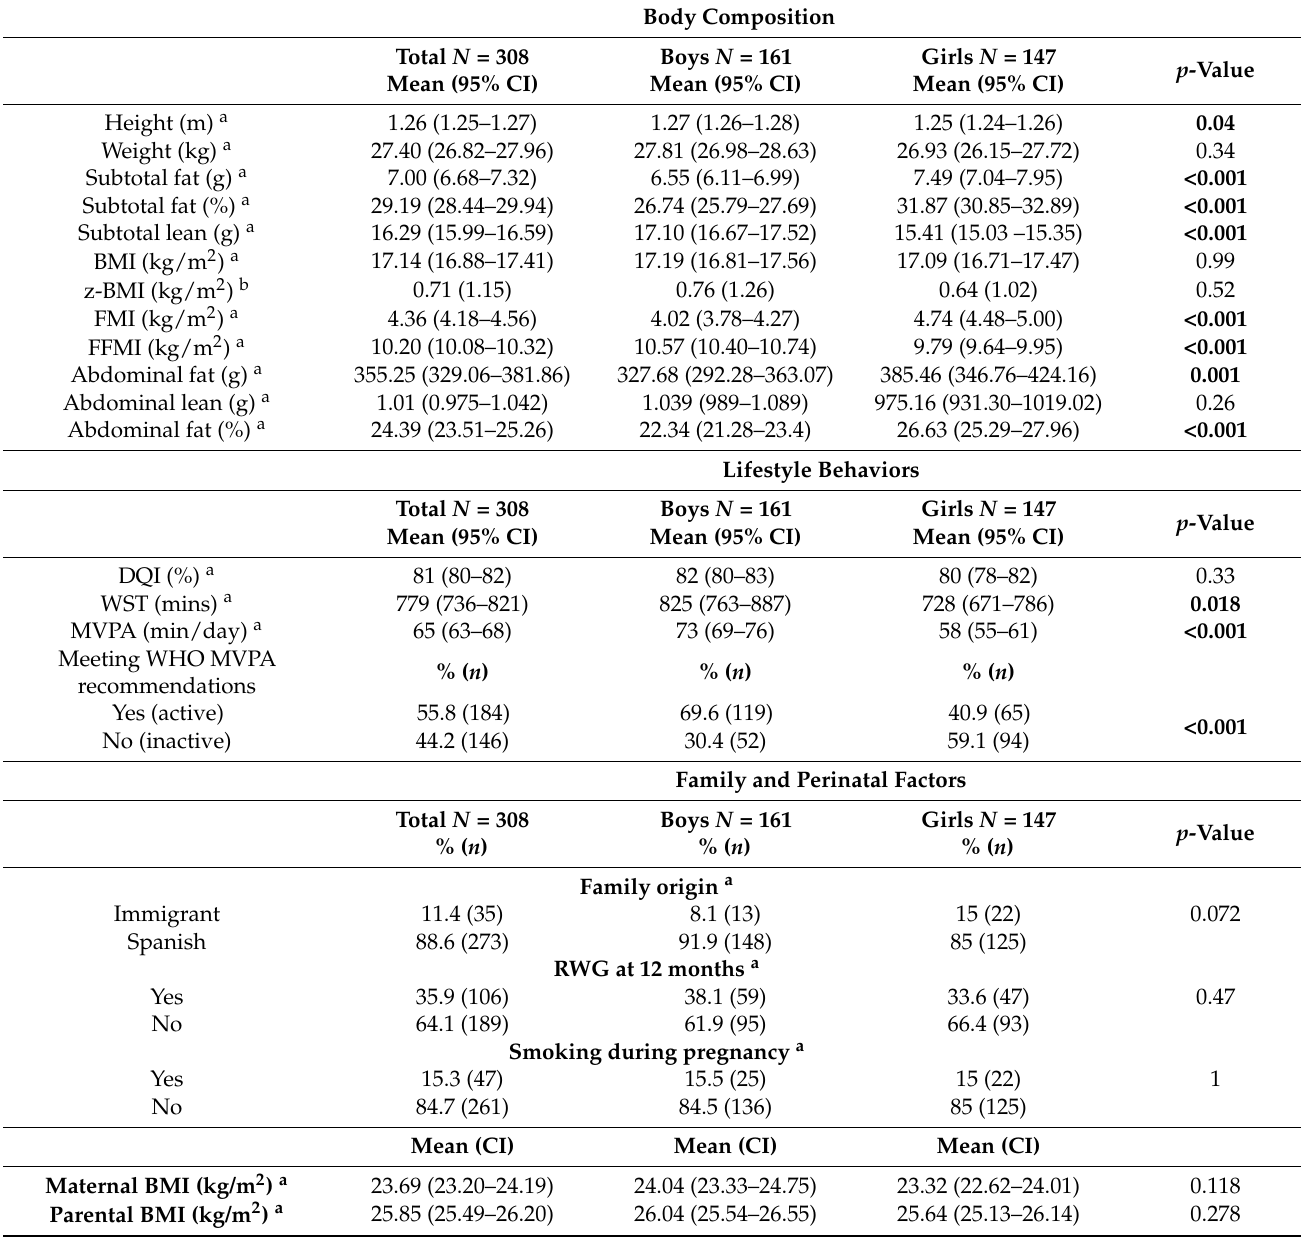
Table 1. Main characteristics of the